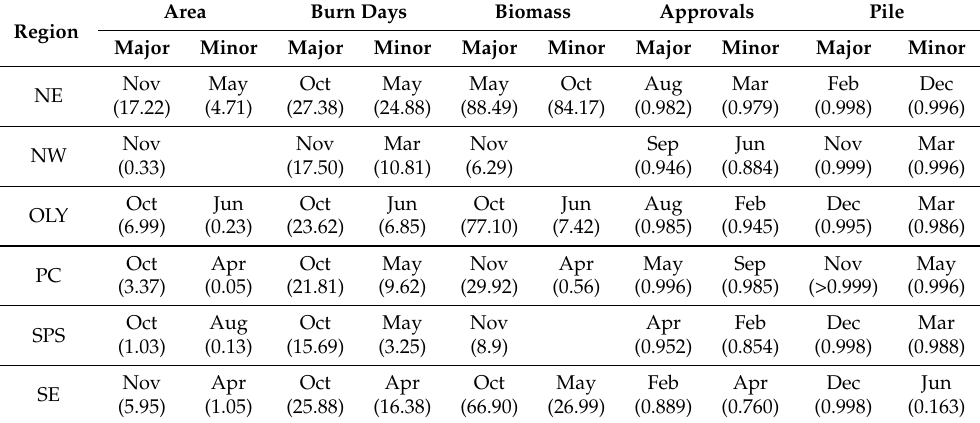
Figure 5. Annual trends of five prescribed fire variables for each DNR administrative region in Washington State. Area burned and biomass burned were square-root transformed for visualization purposes. There is one panel for each prescribed fire parameter: burned area ( a ), number of burn days ( b ), burned biomass ( c ), approval probability ( d ), and pile probability ( e ). Table 4. The major and minor modes of the seasonal profile of prescribed fire parameters by DNR administrative region (Northeast (NE), Northwest (NW), Olympic (OLY), Pacific Coast (PC), South Puget Sound (SPS), and Southeast (SE)). The modal values are reported in the parenthesis. Area burned is reported in thousands of hectares and burned biomass is reported in kilotons. Area Burn Days Biomass Approvals Region